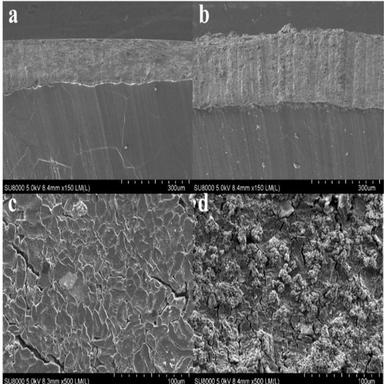
The SEM images of the recycled Li metal anode at the rate of 1 C, vertical view (a) and sectional view (c) of the Co-SPCP/S battery, and vertical view (b) and sectional view (d) of C-MOFs/S battery.